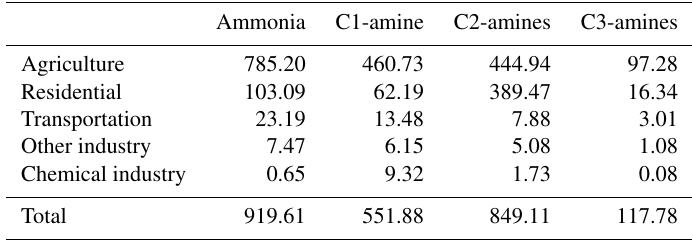
Table 3. Emission rates of ammonia, C1, C2, C3-amines from different sources based on SDR for domain